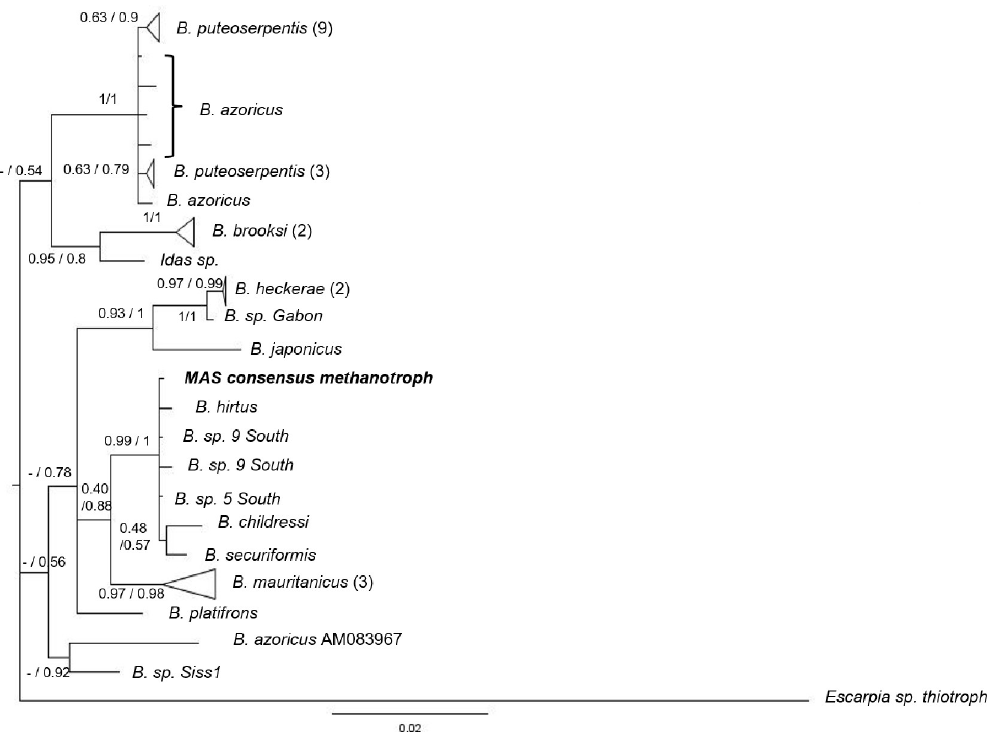
Fig 4. 16S Bayesian phylogram based upon 16S sequences from known endosymbionts from bathymodiolins and other deep-sea hosts. The nodes are labeled with the ML probabilities based on 500 bootstrap replicates before the slash and Bayesian posterior probabilities after the slash. If the node placement did not agree between the two trees, a “-” is indicated before the slash. The branch tips are labeled with the name of the host species. If more than one sequence from that host is represented in that clade, the sample size is in parentheses after the name. A Gammaproteobacteria thiotroph from a hydrocarbon seep tubeworm, Escarpia sp . (JF969172), was used as an outgroup. Our consensus sequence, M, is in bold. S8 Table contains Genbank accession numbers of all individuals in the